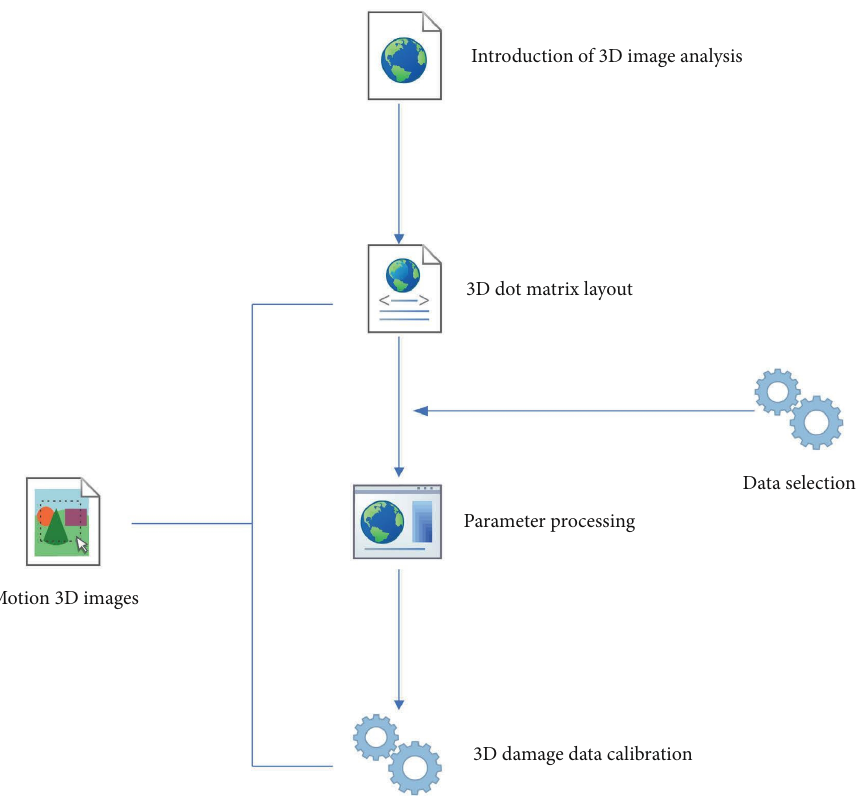
Figure 2: Implementation of a 3D image analysis-based motion injury pose acquisition